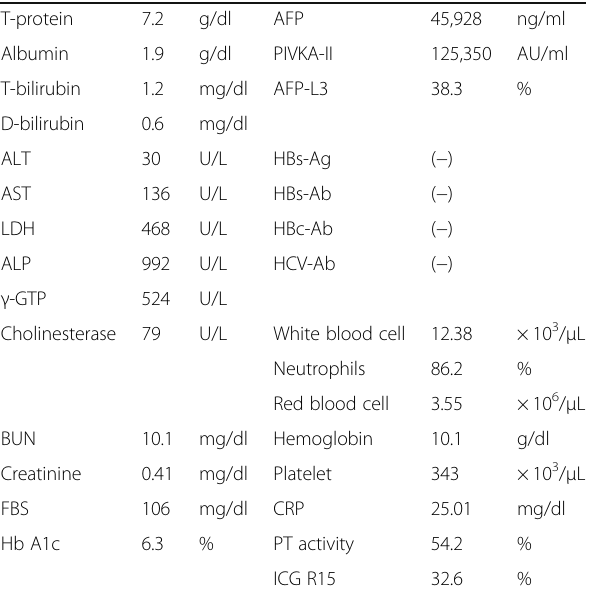
Table 1 Laboratory values on admission